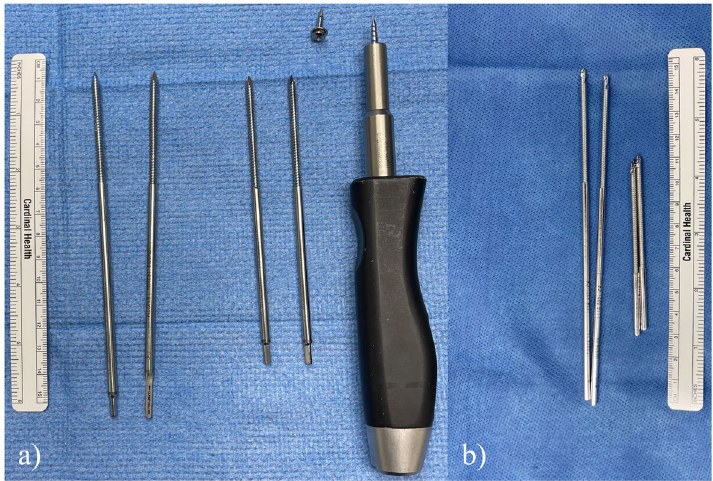
Fig. 1 Tracking pins from the a large pin diameter and b small pin diameter robotic-assisted total knee arthroplasty systems. The longer pins in both images are the femoral pins, while the shorter pins are the tibial